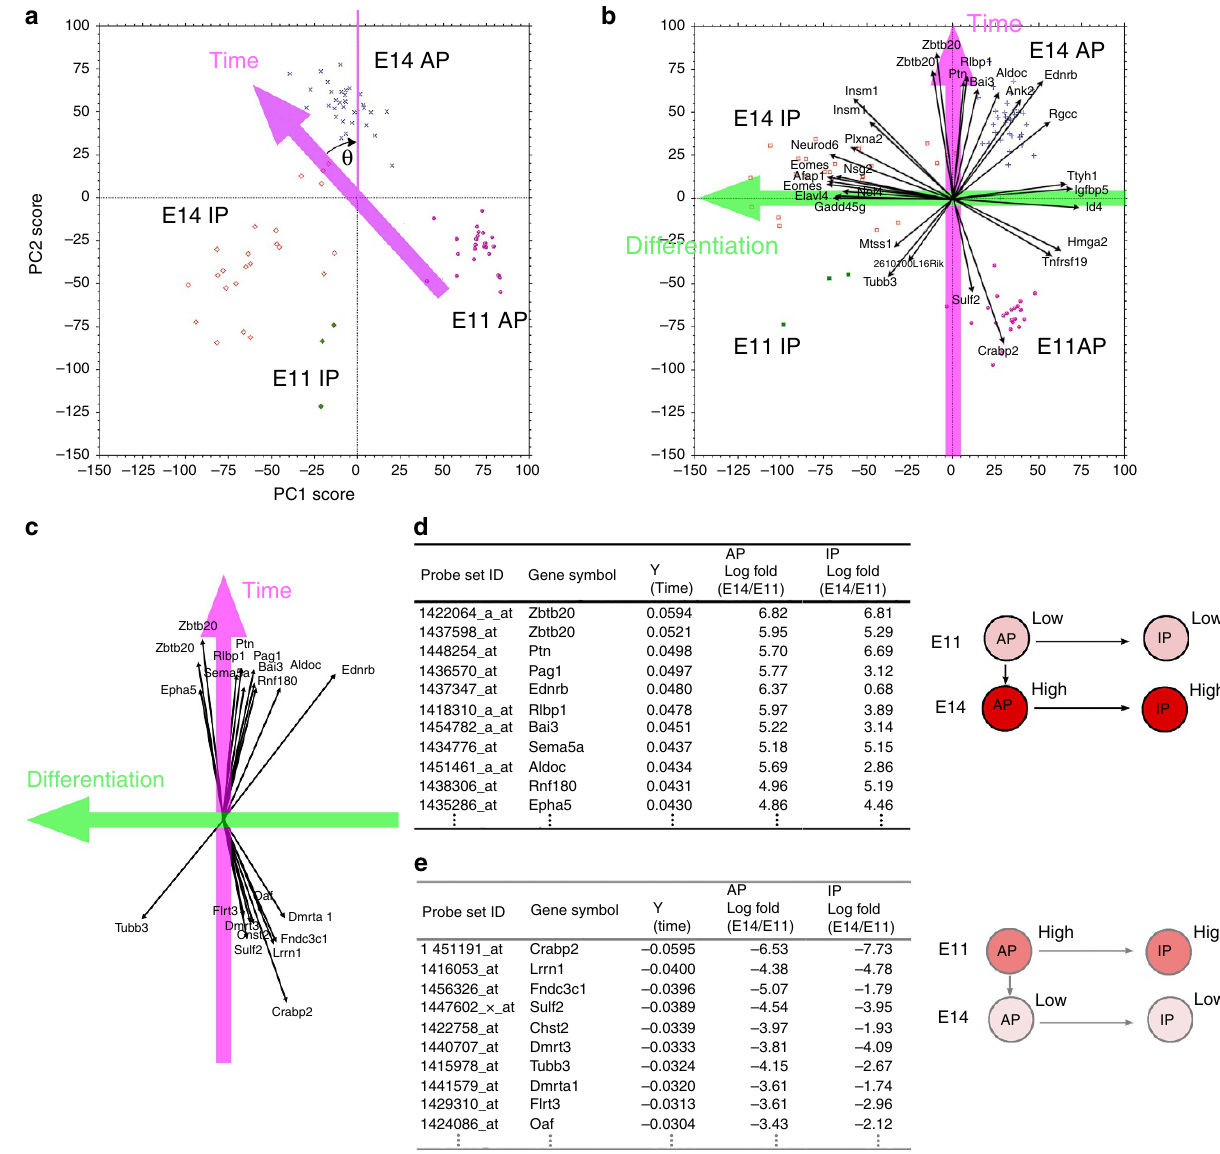
Figure 3 | Expression change in an individual gene can be described by the temporal and differentiation axes. ( a ) PCA was performed using microarray data from single-cell cDNAs of E11 and E14 progenitor (AP þ IP) cells (E11, N ¼ 23; E14, N ¼ 56; 17,192 probe sets). Each symbol represents one cell. Plots for individual cells, categorized into one of four groups (E11 APs, E11 IPs, E14 APs and E14 IPs), are almost completely separated in a two-dimensional PCA graph. To make the new Y axis the temporal axis, graph a was rotated such that the median new X values of E11 APs and E14 APs were equal ( y E 43.35 (cid:2) ) (graph b ). ( b ) Distribution of four progenitor groups and vectors of the 30 genes with the largest vectors showed that the new X axis primarily reflects differences between APs and IPs, and thus represents the differentiation axis. ( c – e ) Temporal-axis genes. The top 10 genes that made the largest positive or negative contributions to the temporal axis were selected and shown as a vector ( c ) or in tables ( d , e ). These genes roughly overlapped with the main PC1 genes from PCA of E11, E14, and E16 APs (Fig. 2c). Log fold-change values of expression levels showed that these genes exhibited an E11-low/E14-high pattern (or vice versa) in both APs and